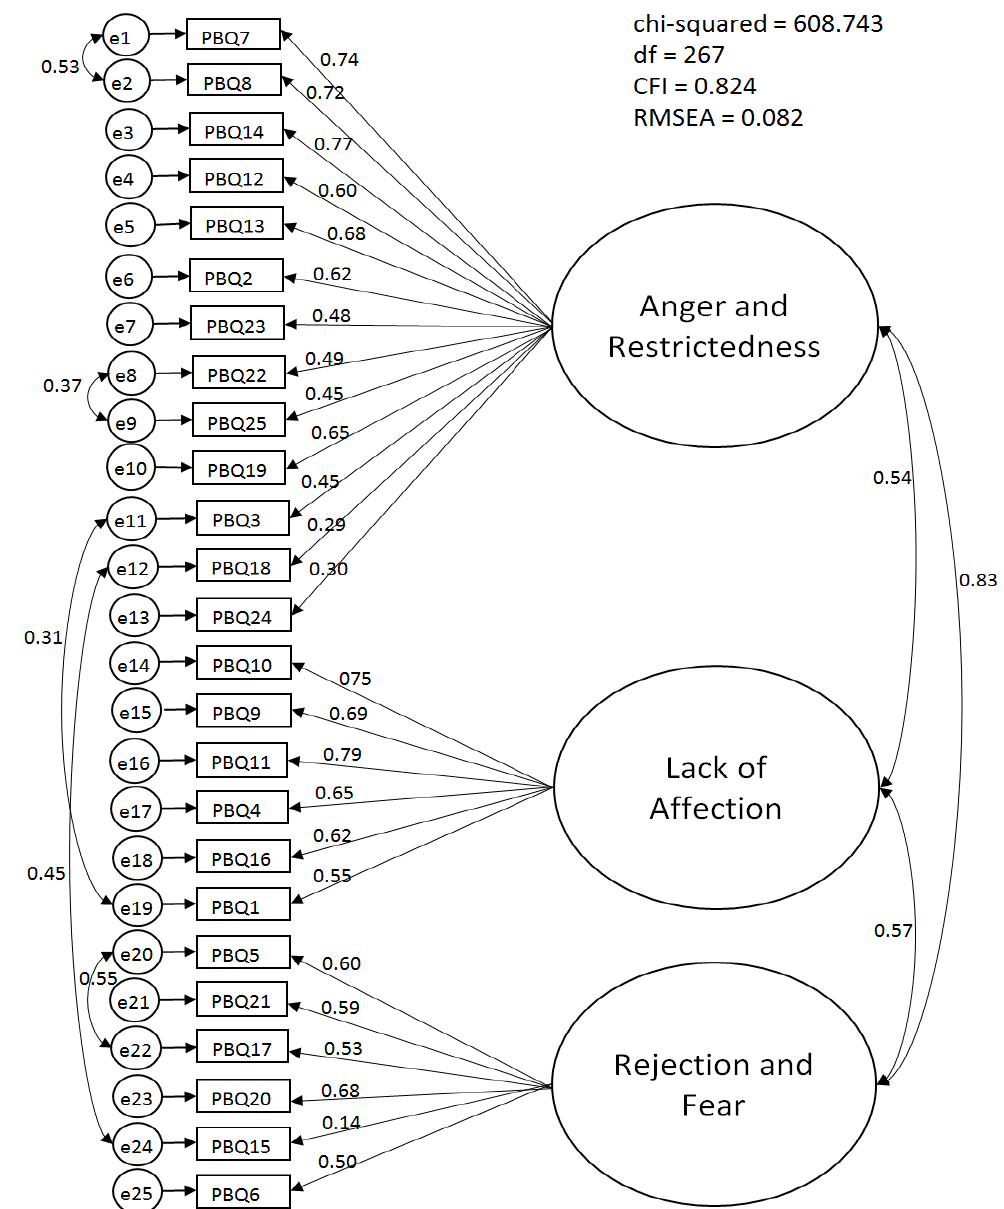
Figure 1. Confirmatory factor analysis of the Postnatal Bonding Questionnaire (PBQ).